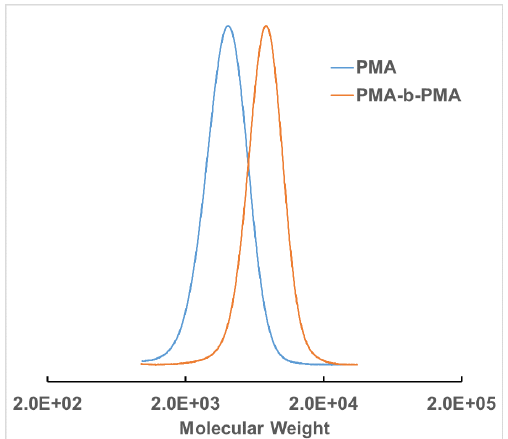
Figure 2. GPC curves of the chain extension experiment with PMA 43 –Br as the macroinitiator. [ MA ] 0 : [ PMA 43 − Br ] [ CuBr 2 ] [ Me 6 TREN ] = 50 : 1 : 0.0025 : 0.005 at 60 ◦ C with 50mmol MA in 5mL of 0 : 0 : 0 DMF; 0.04mmol CuBr/Me 6 TREN in 2mL MeCN was added in 2h. Before chain extension, M n = 3700, M w / M n = 1.15; after chain extension, M n = 7300, M w / M n =